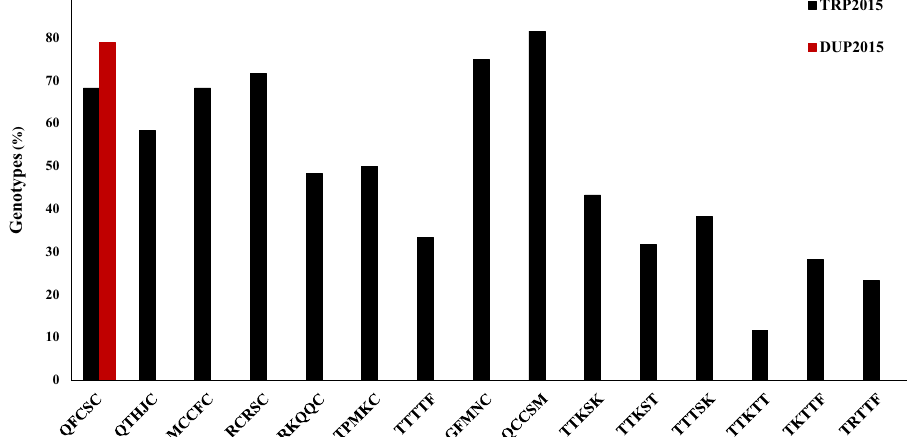
Figure 1. The percentage of genotypes showing resistance to different stem rust races. Red column represents the percentage of resistance genotypes in the DUP2015 nursery, while black columns represent the percentage of the resistance genotypes in the TRP2015 nursery.